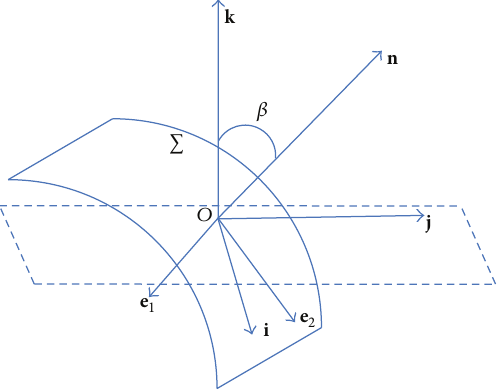
Figure 3: The same as Figure 2 in case of one direction is normal to vector k